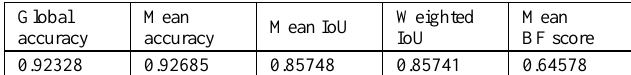
(Fig. 11). Results of SIS without DropOut are even worse.